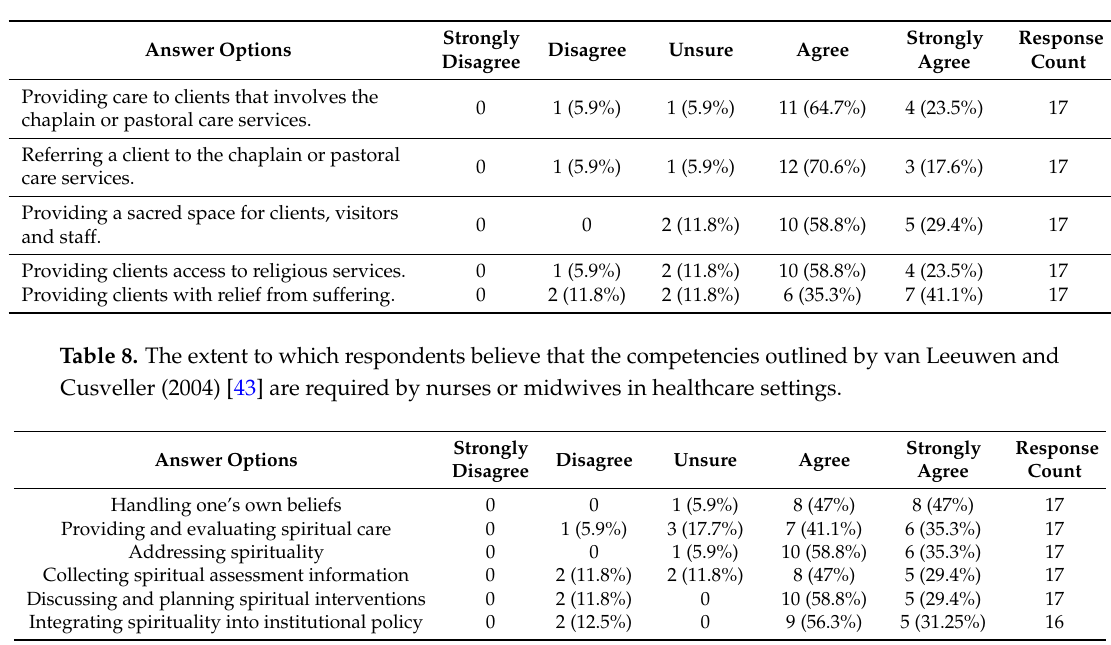
Table 7. Activities that are relevant to the provision of spiritual care in healthcare settings.